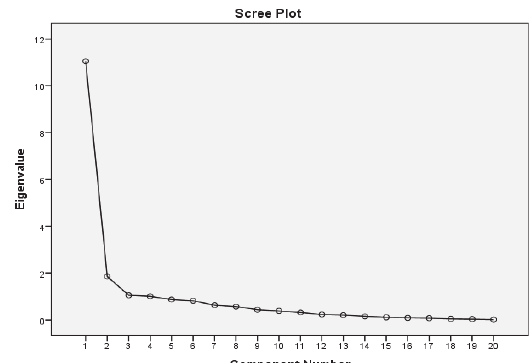
Fig. 1. Aggregate of latent roots corresponding to various